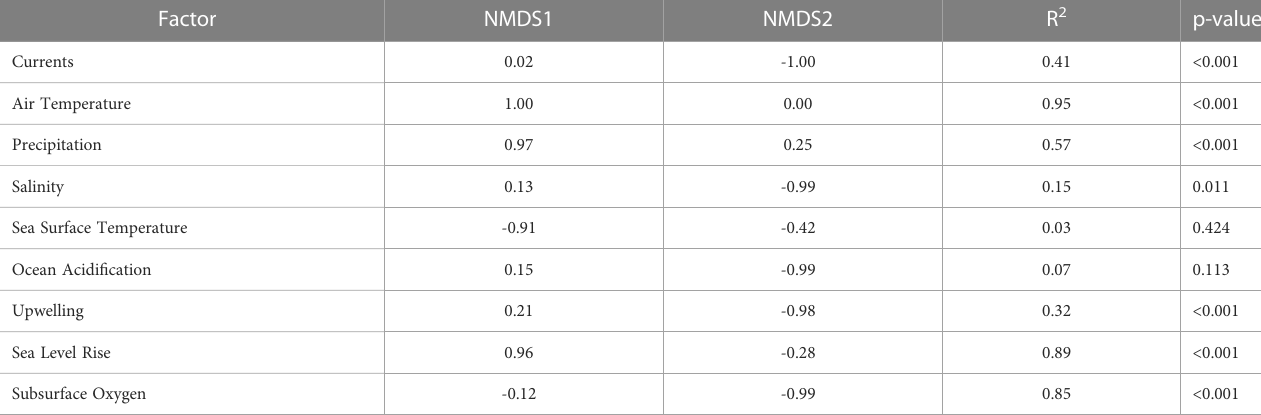
TABLE 7 Results from linear models relating the NMDS axes scores to each of the climate exposure